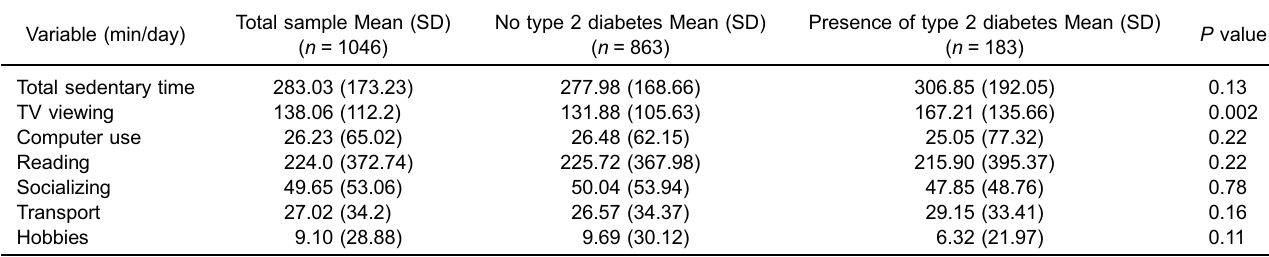
Table 2. Domain-speci fi c sedentary behaviors by type 2 diabetes